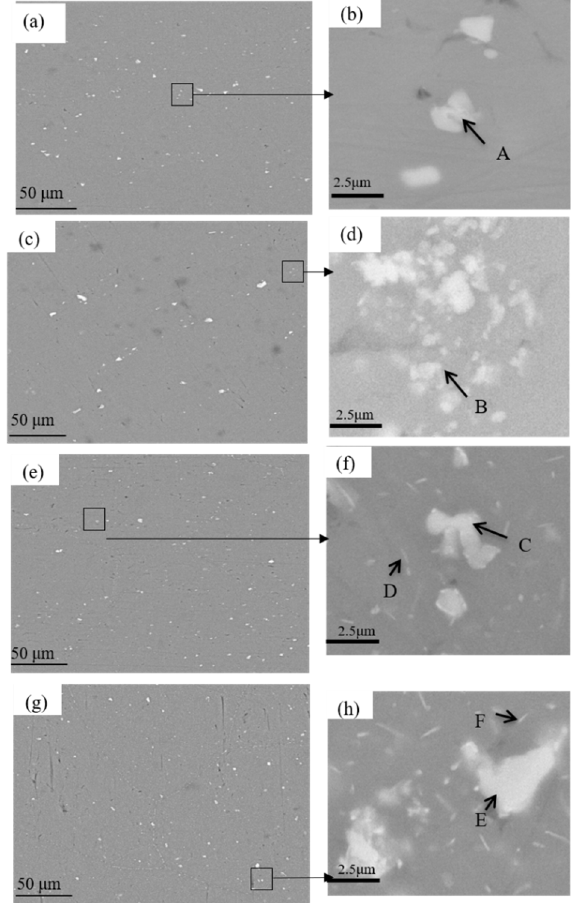
Figure 2. SEM images of the samples under DA and 295 °C isothermal treatments: ( a , b ) DA; ( c , d ) 100 s; ( e , f ) 800 s; ( g , h ) 1500 s.